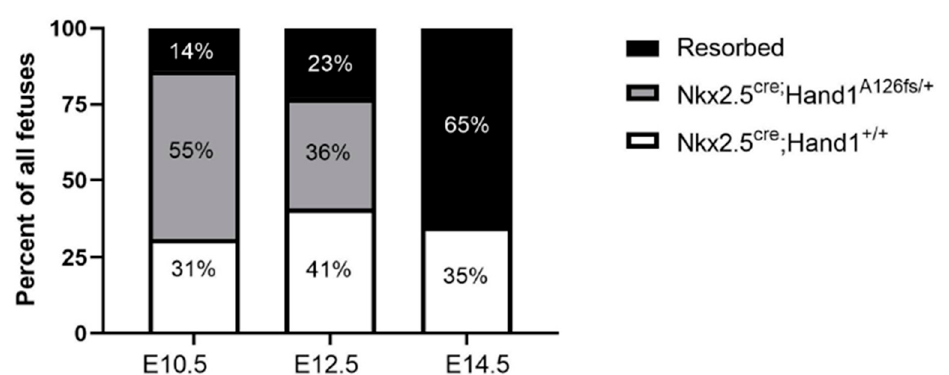
Figure 2. Percentages of resorptions (black), Nkx2-5 Cre ;Hand1 A126fs/+ (grey) and Nkx2-5 Cre ; Hand1 +/+ (white) embryos in litters recovered at embryonic day 10.5 (E10.5), E12.5 and E14.5. From E10.5, embryos with the Nkx2-5 Cre ;Hand1 A126fs/+ genotype show increased fetal demise. Nkx2-5 Cre ;Hand1 A126fs/+ fetuses were overrepresented at E10.5 (55%); however, they showed a marked decrease at E12.5 (36%) and no viable fetuses were recovered at E14.5. n = 4–8 litters